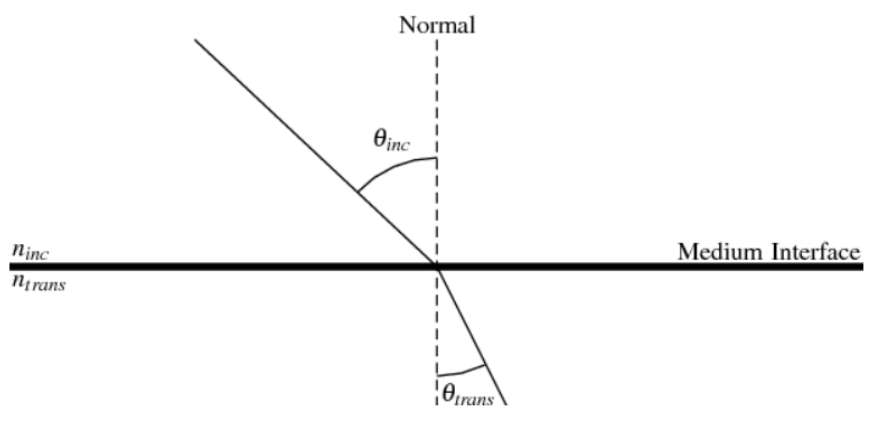
Figure 2. Example of the refraction phenomenon of the signal where n inc and n tran are the refractive indices of the incident and transmitted medium,